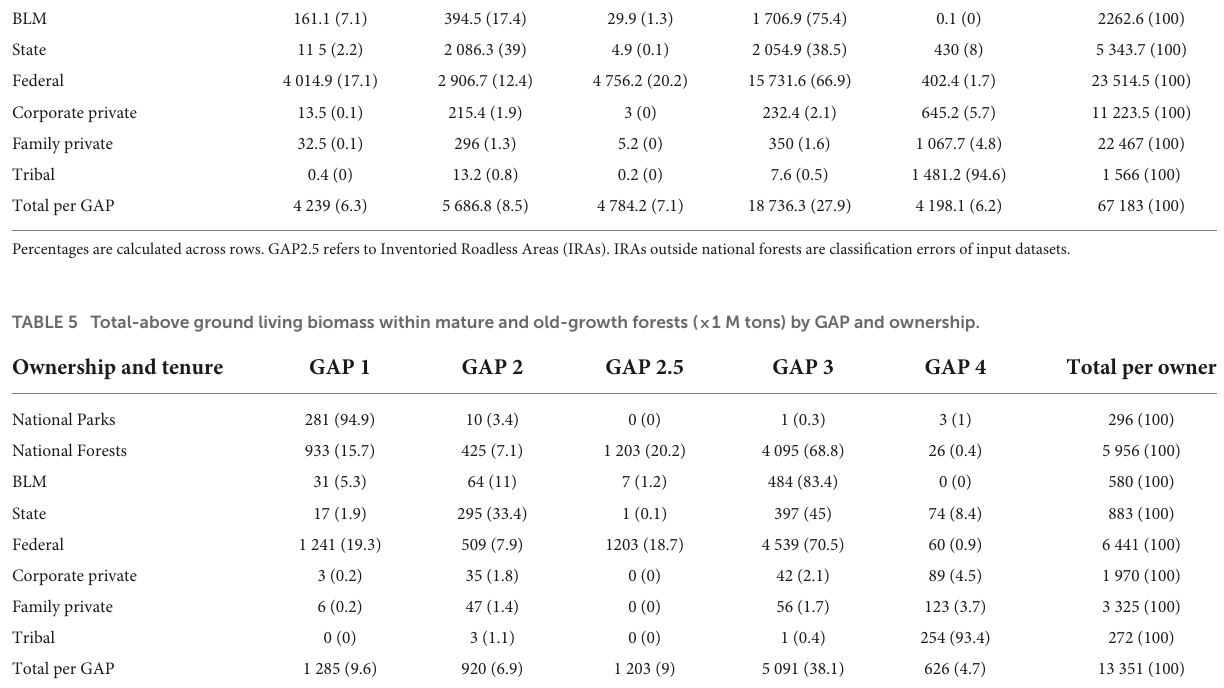
TABLE 4 Total area of mature and old-growth forests ( × 1000 ha) and percent (parenthesis) for the conterminous United States by GAP and ownership.